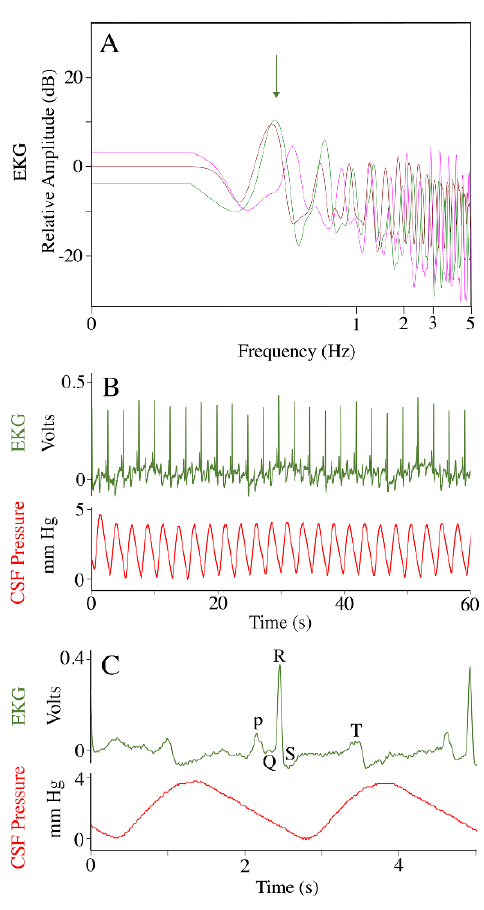
Figure 1. The EKG and cardiac-related CSF pressure pulsations. These sequences were recorded during a period of induced apnea, so no ventilatory influence is evident. ( A ) Power spectral analyses of the EKG traces from three individuals of Alligator mississippiensis (individuals’ traces are color- coded), all have a dominant frequency near 0.4 Hz (vertical arrow) corresponding to a heart rate of 24 beats per minute. ( B ) Simultaneously recorded EKG (dark green) and CSF pressure (red) tracings, showing the clear identification of the cardiac-related CSF pressure pulses. ( C ) simultaneously recorded EKG (dark green) and CSF pressure (red) tracings; the CSF pressure rises after the ventricular expulsion of the arterial blood (the QRS phase of the cardiac cycle). c—individual cardiac-related pulsation.